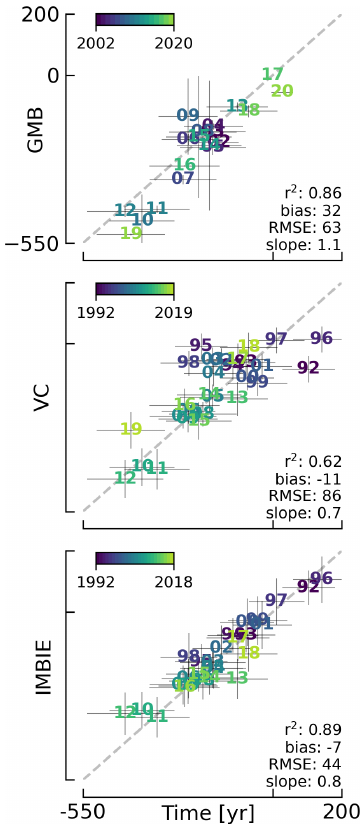
Figure 7. This Study total mass balance (MB) vs. the gravimetric method (GMB), volume change method (VC), and IMBIE2 esti- mates of MB. All three include BMB. All axis units are Gtyr − 1 . Plotted numbers represent the last two digits of the year. GRACE and IMBIE2 include peripheral ice